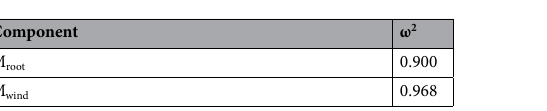
Table 2. Effect size of components on root anti-lodging index at wind grade 6.